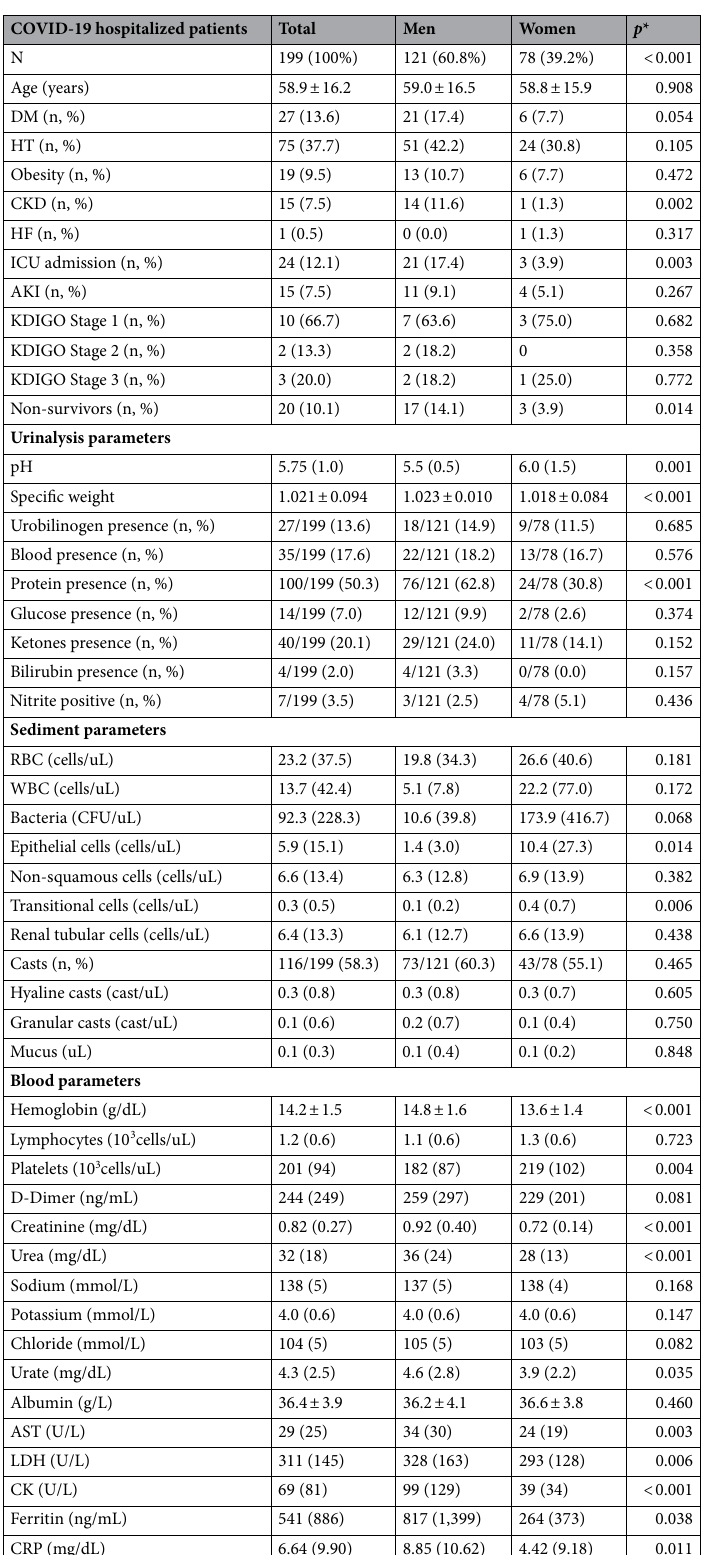
Table 1. Clinical data and biochemical parameters of COVID-19 hospitalized patients. (*) men-women comparison; Quantitative variables were described by mean ± standard deviation or median (IQR);